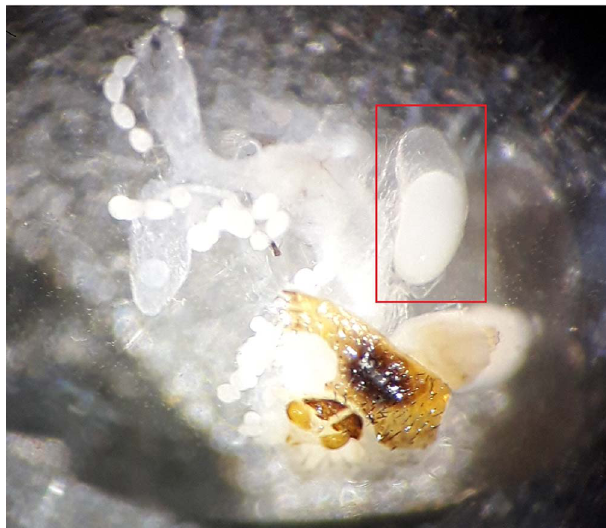
Figure 2. Degenerated egg (framed in